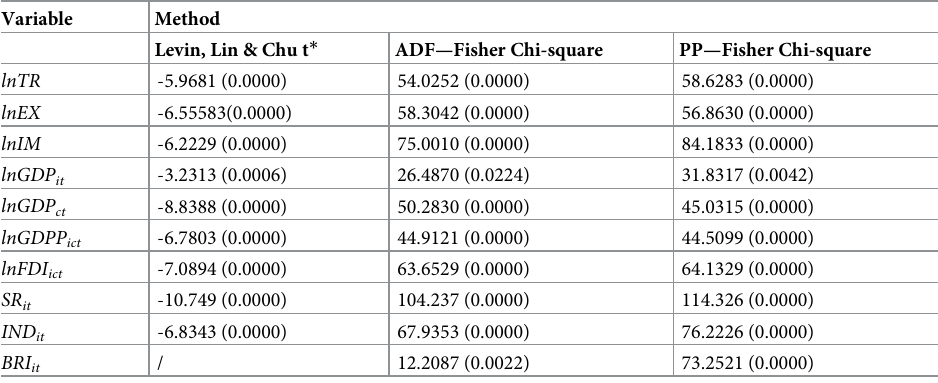
Table 5. Summary of unit root test in 1st difference.